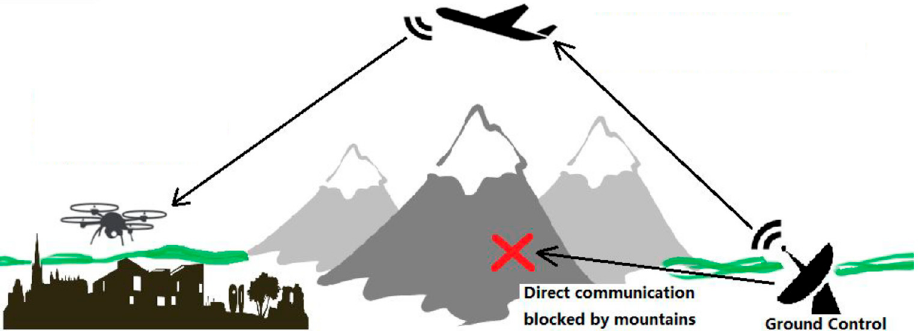
Figure 1. Application scenarios of UAV communication relay system.